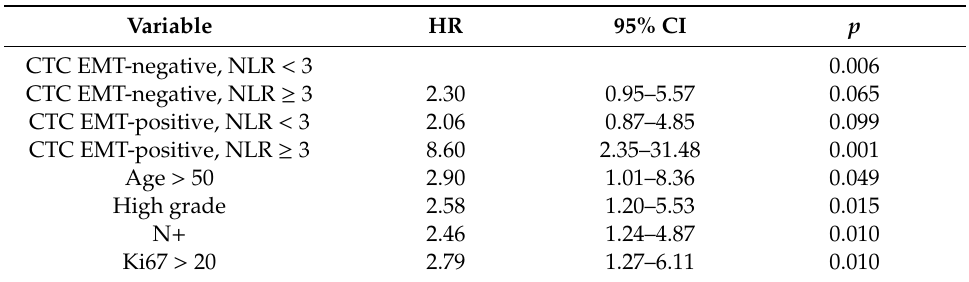
Table 3. Cox proportional hazard regression analysis for the association between CTC EMT and NLR status, clinical predictor variables, and PFS.